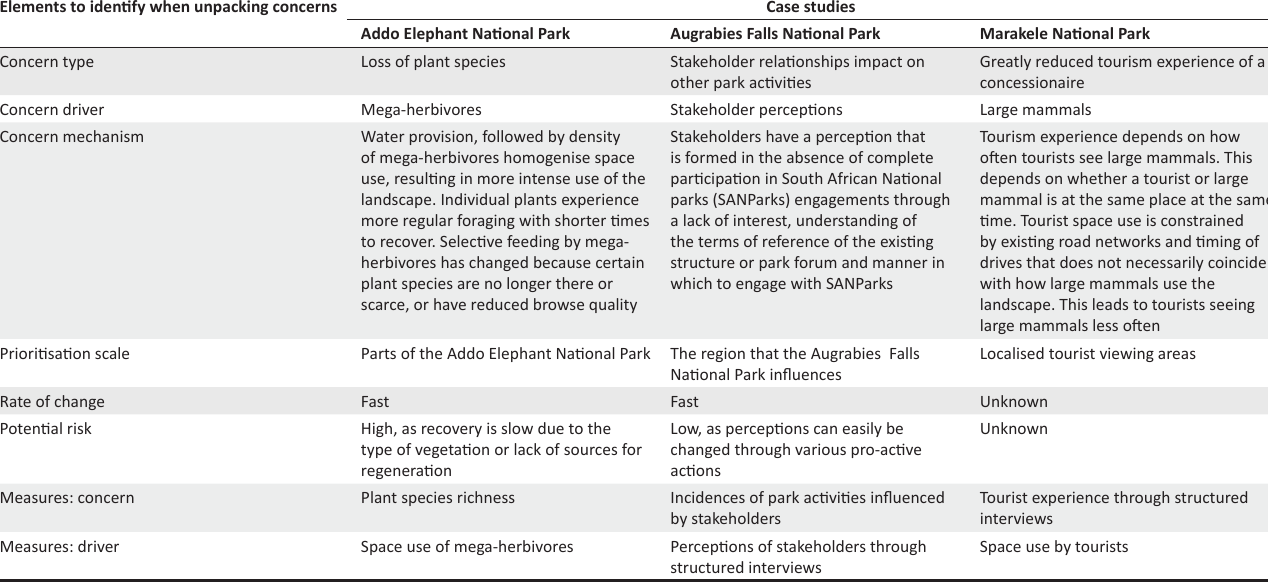
TABLE 1: Three case studies of different types of concerns unpacked in three different national parks in South Africa. Elements to identify when unpacking